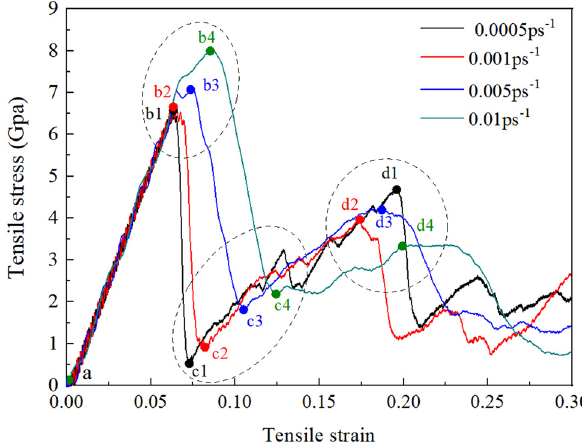
Figure 5: Stress – strain curves of di ff erent strain at 300